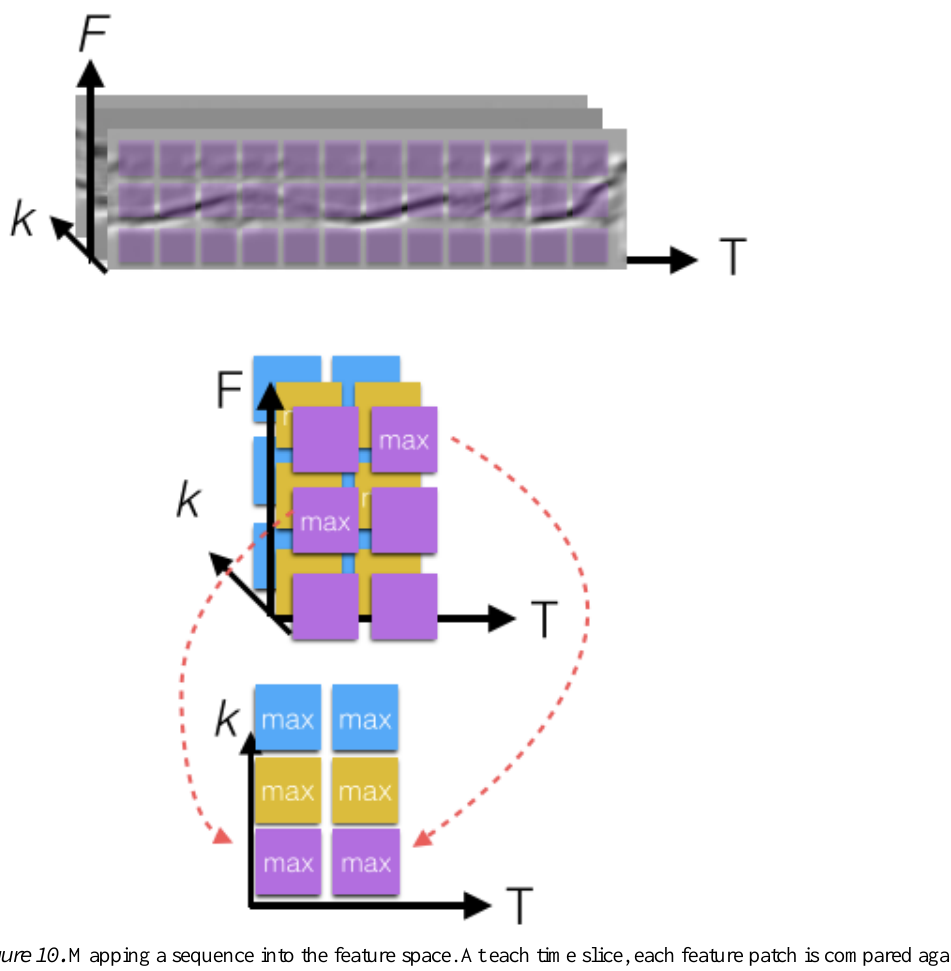
Figure 10. Mapping a sequence into the feature space. At each time slice, each feature patch is compared against the spectrogram at that time over all frequencies (vertical axis). The maximum response is saved for each feature, which results in a k-dimensional series of values through